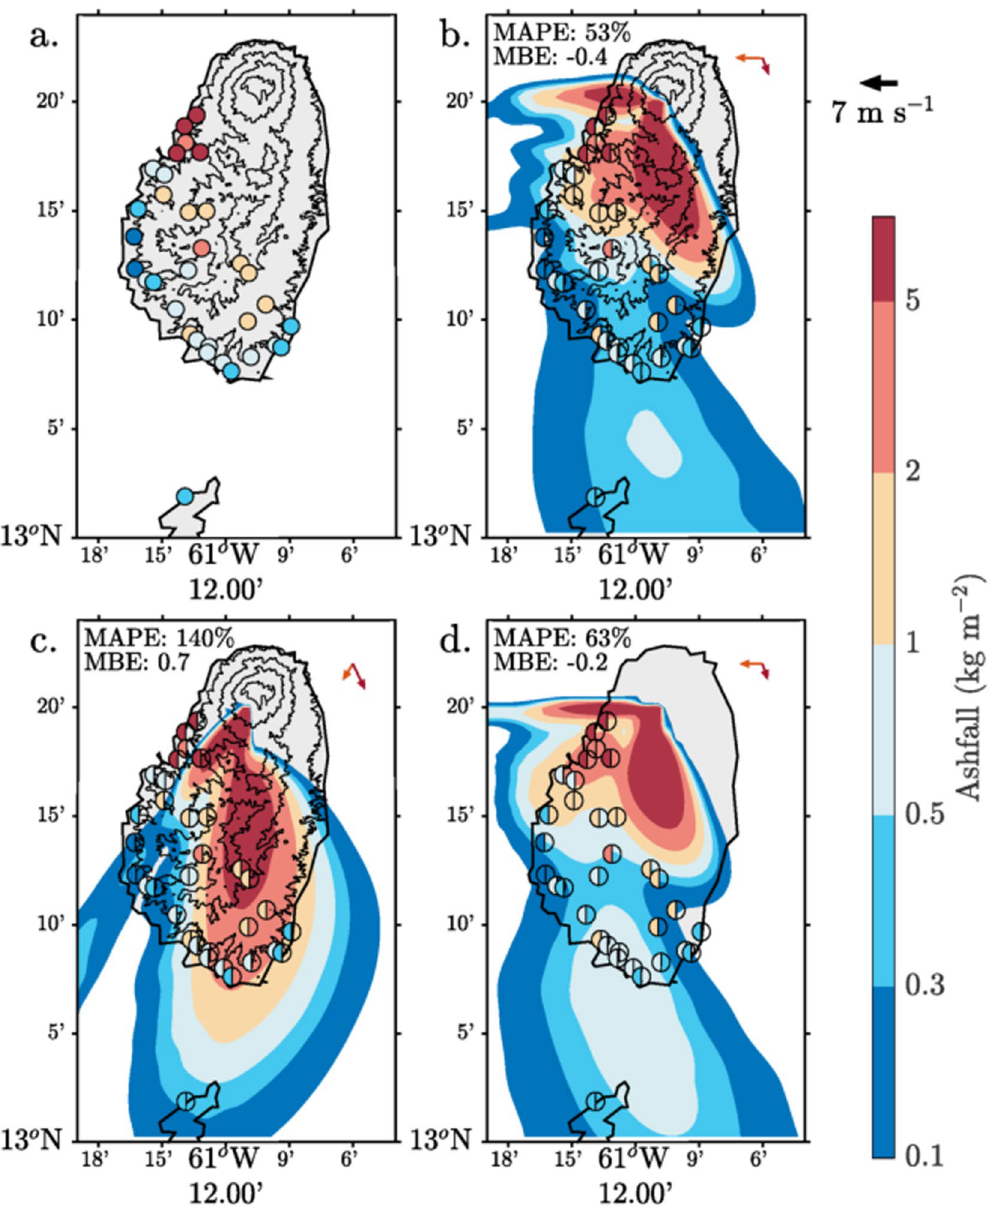
Figure 1. Ash fall distributions following the 26 April 1979 eruption of Soufriere St Vincent. ( a ) Observed, ( b – d ) simulated from the meteorological-ash-dispersion model, where the experiments are ( b ) Control; ( c ) Alternative Wind profile (lower shear); and ( d ) Flat Topography. Observations are plotted over the contours using filled circles markers. In Panels b–d observations correspond to the left half of the marker and modelled values to the right. Topographic contours are shown at 100 m and every 300 m after that. Domain-averaged wind vectors at 100 m (orange) and averaged between 6–12 km (dark red) are shown in the top right corner. Plotted using MATLAB Release 2016b, The MathWorks, Inc., Natick, Massachusetts, United